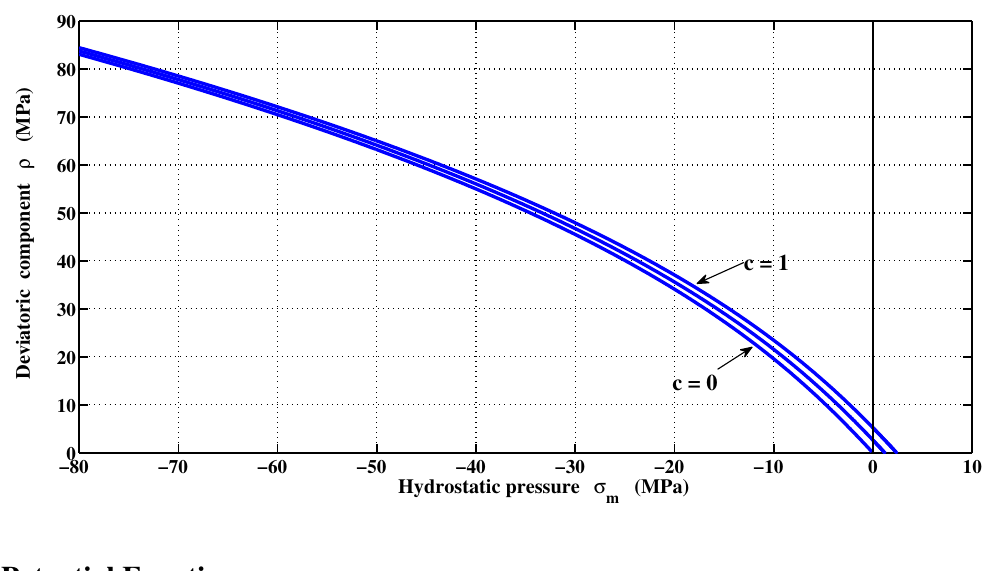
Figure 5. Triaxial failure envelope in softening